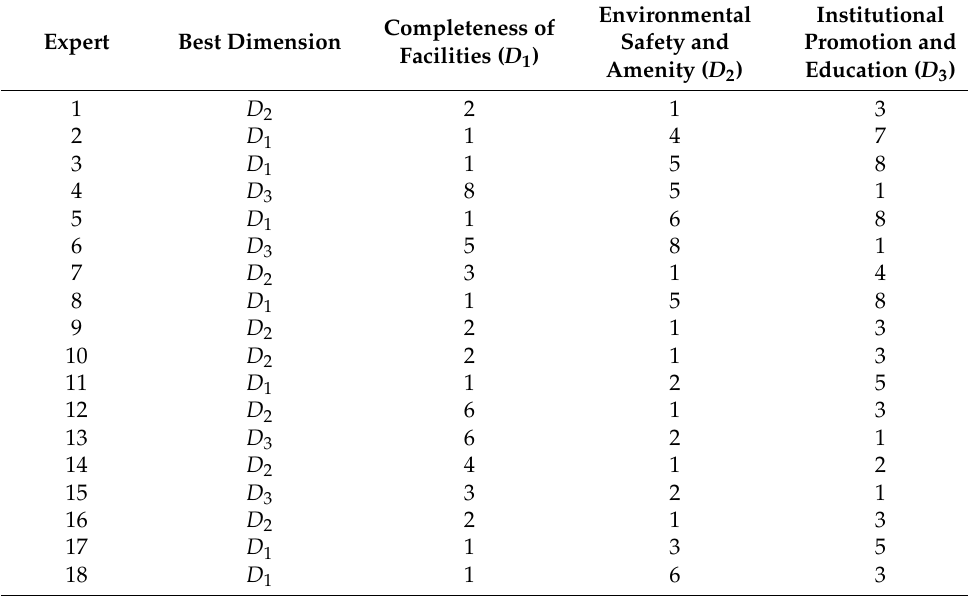
Table 4. BO vectors of the three dimensions.